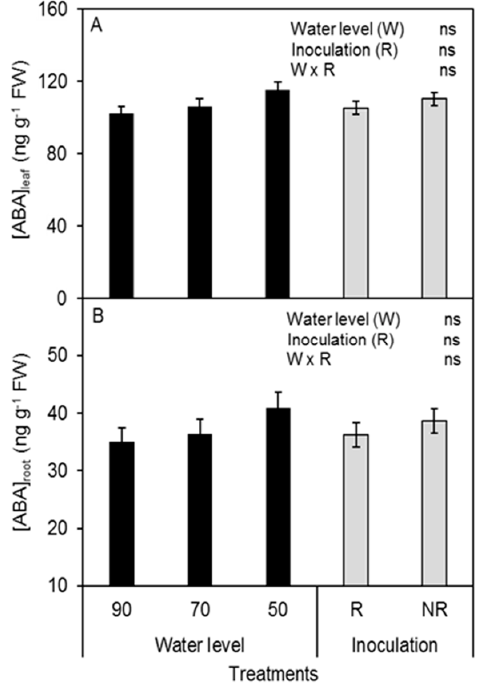
Figure 5. ( A ) Leaf abscisic acid and ( B ) root abscisic acid (ABA) concentration of cowpea under different soil water regimes (90%, 70%, and 50% of SWHC) and rhizobia inoculation. Values are means + SE (n = 8 for 90%, 70%, and 50% of SWHC treatments and n = 12 for R and NR treatments).